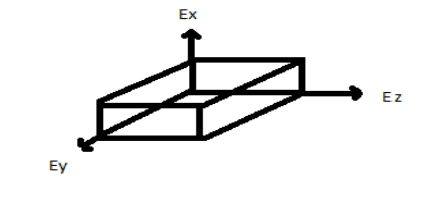
Figure 1: Scattering volume ∆𝑉 =